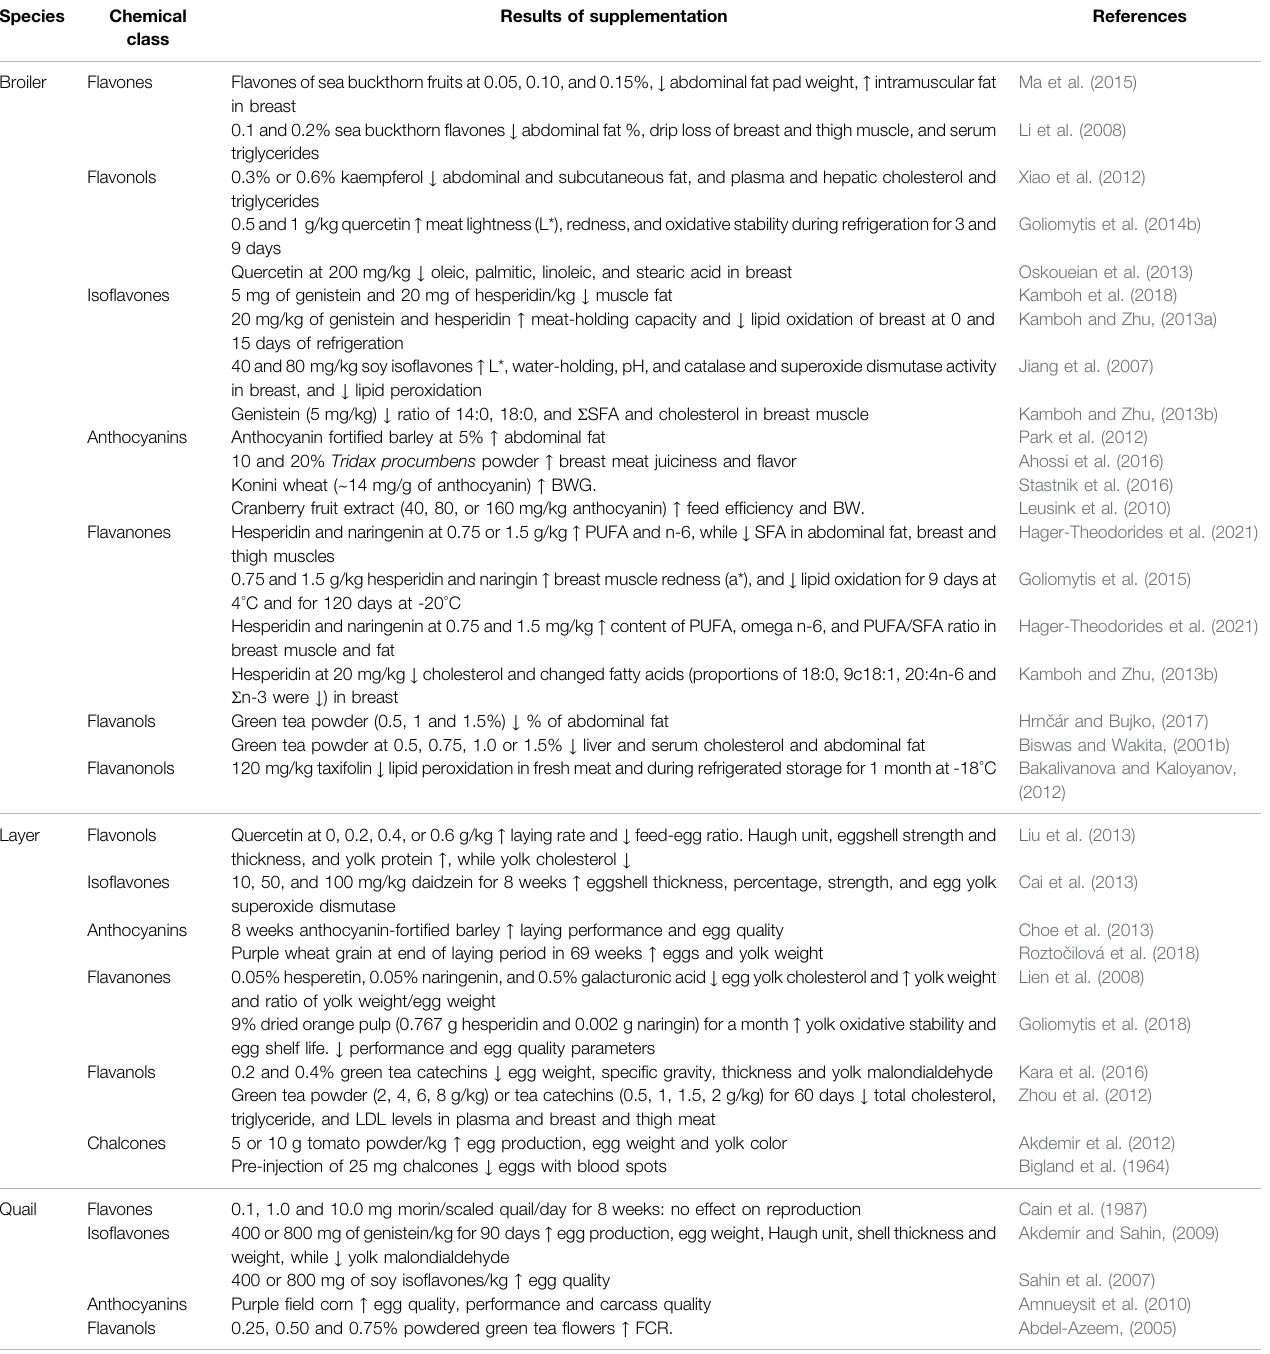
TABLE 1 | Flavonoids and effects on body fat, meat quality/composition and egg quality in poultry.